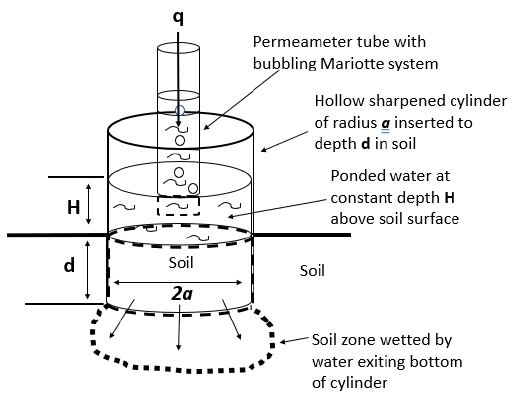
Figure 2. Diagram of system for measuring K sat in surface horizons.